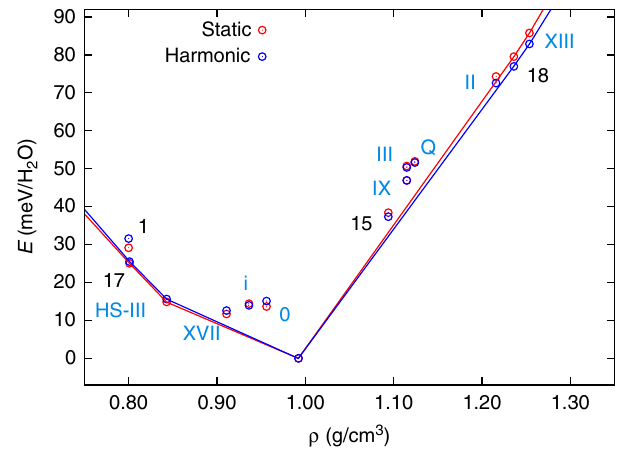
Fig. 2 Energy-density convex hull. PBE-DFT static lattice energies (red) and free energies including harmonic vibrations (blue) relative to ice Ih for known ice phases (blue labels) and energetically competitive phases (black labels). The labels of the novel energetically competitive phases correspond to the numbering scheme in Fig. 3. The energy-density convex hulls at the static lattice and harmonic vibrational levels are indicated by red and blue solid lines,